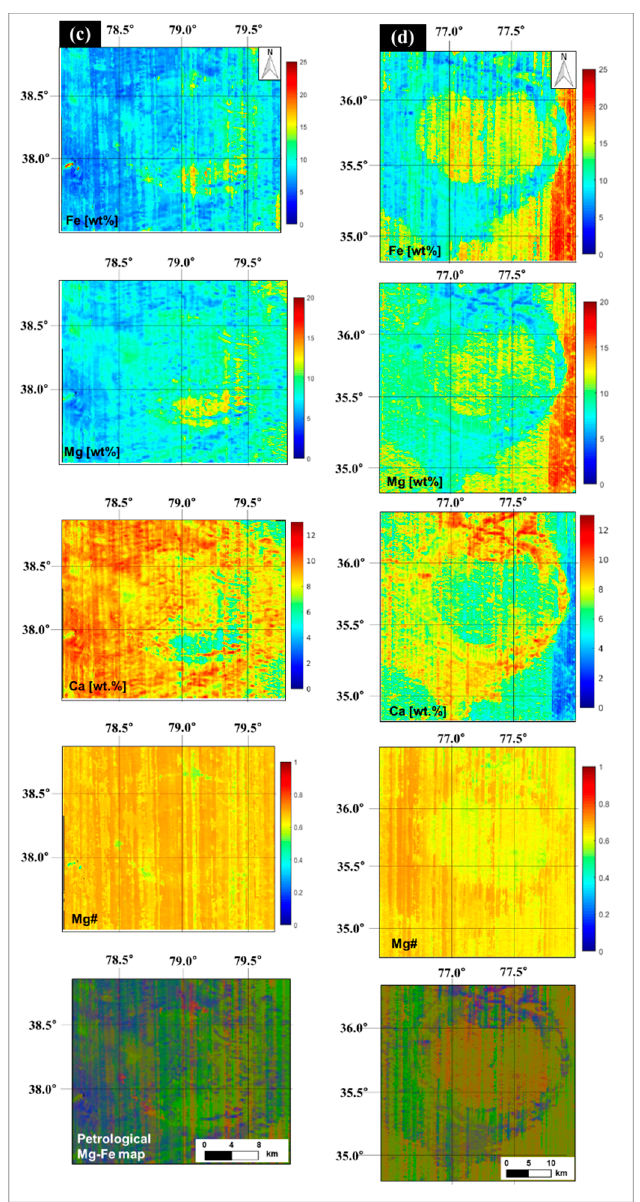
Figure 3. Maps indicating the elemental abundances of Fe, Mg and Ca, the Mg# (Mg/(Mg+Fe)), and the petrological Mg-Fe map in the study area [28,34–36]. The Fe abundance distribution appears from 0 wt% (blue, lowest abundance) to 25 wt% (red, highest abundance). The Mg abundance distribution made of 0 wt% (blue) to 10 wt% (red). The Ca abundance is distributed from 0 wt% (blue) to 12 wt% (red). The Mg# distribution is shown with the same color scale, but the color indices appear from 0 (blue) to 1 (red). In the petrological Mg-Fe map, red and orange denotes mare basalts, green denotes Mg-rich rocks, and blue denotes anorthosite. ( a ) Lavoisier and Lavoisier F, ( b ) Lavoisier E, ( c ) Lavoisier H, ( d ) Lavoisier C. The spatial resolution of the petrological Mg-Fe map is 140 m/pixel.